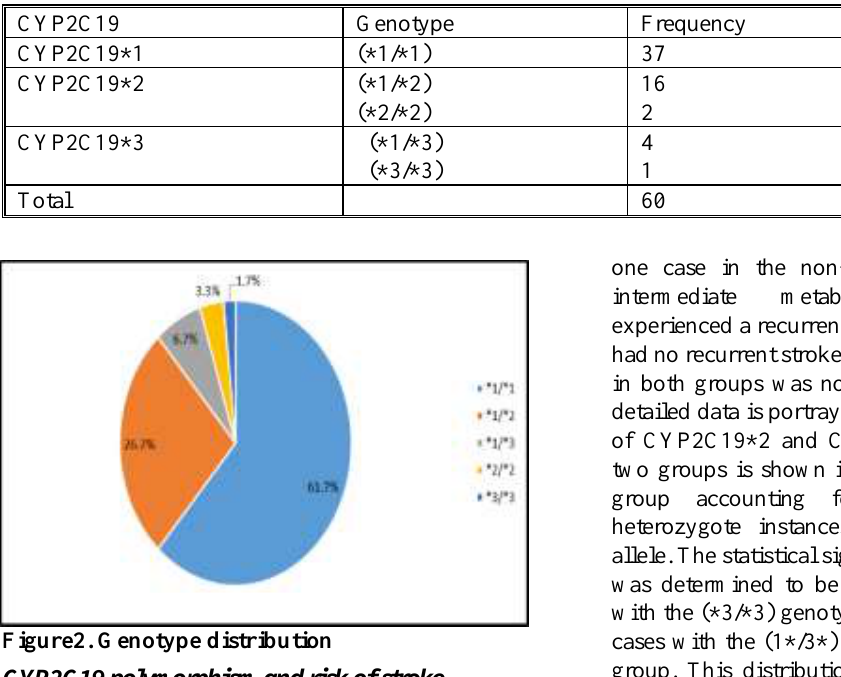
Table 2. Genotype distribution of CYP2C19.